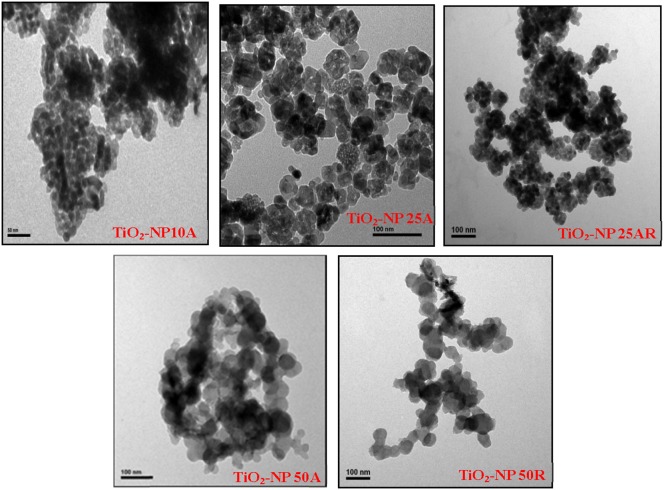
TEM images of the as-received TiO2 NPs.